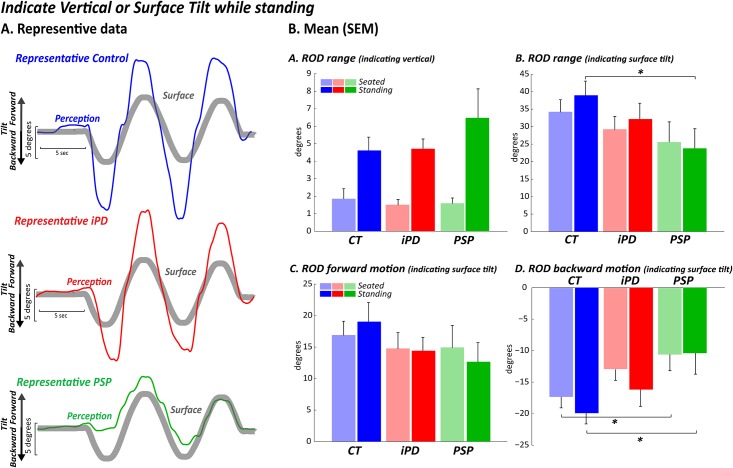
Perception of gravitational vertical and support surface orientation during platform oscillations.Using an instrumented rod, healthy control subjects and iPD subjects similarly overestimated surface orientation, consistent with previous studies. In contrast, subjects with PSP showed reduced perception of surface movement and nearly absent perception of backward surface tilt. AP: anterior-posterior A) Rod range when indicating vertical in seated and standing conditions (difference from vertical) B) Rod range when indicating surface tilt in seated and standing conditions C) Rod maximum forward motion when indicating surface tilt in seated and standing conditions D) Rod minimum backward motion when indicating surface tilt in seated and standing conditions.